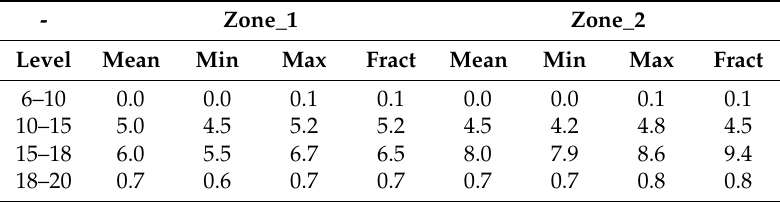
Table 8. Interstory drifts ratio (in percentage) evaluated via NLTH with α g = 1.0.